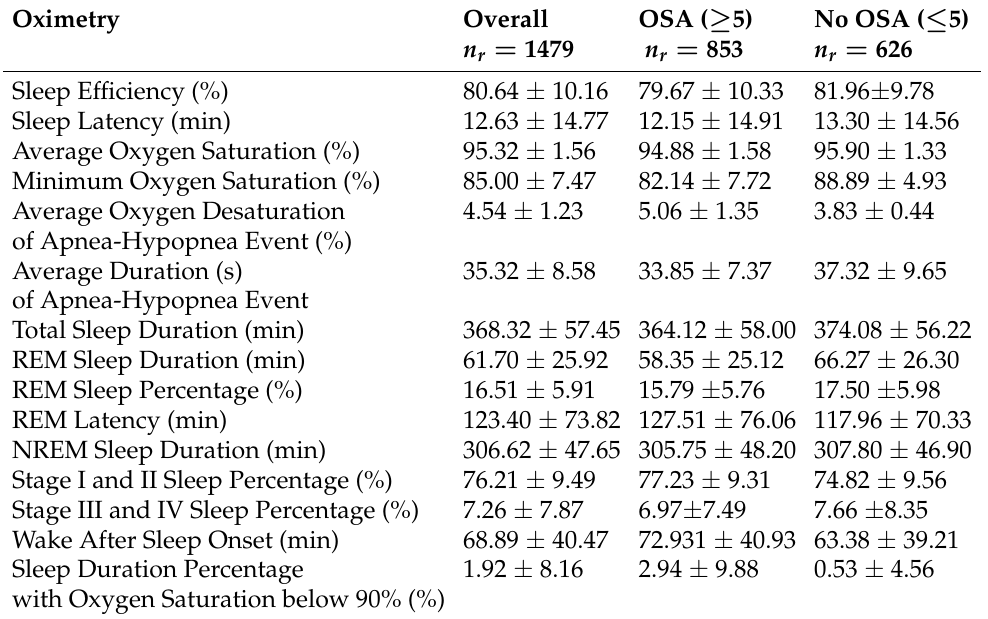
Table A8. PSG-derived oximetry characteristics of cohort expressed as mean ± standard deviation.